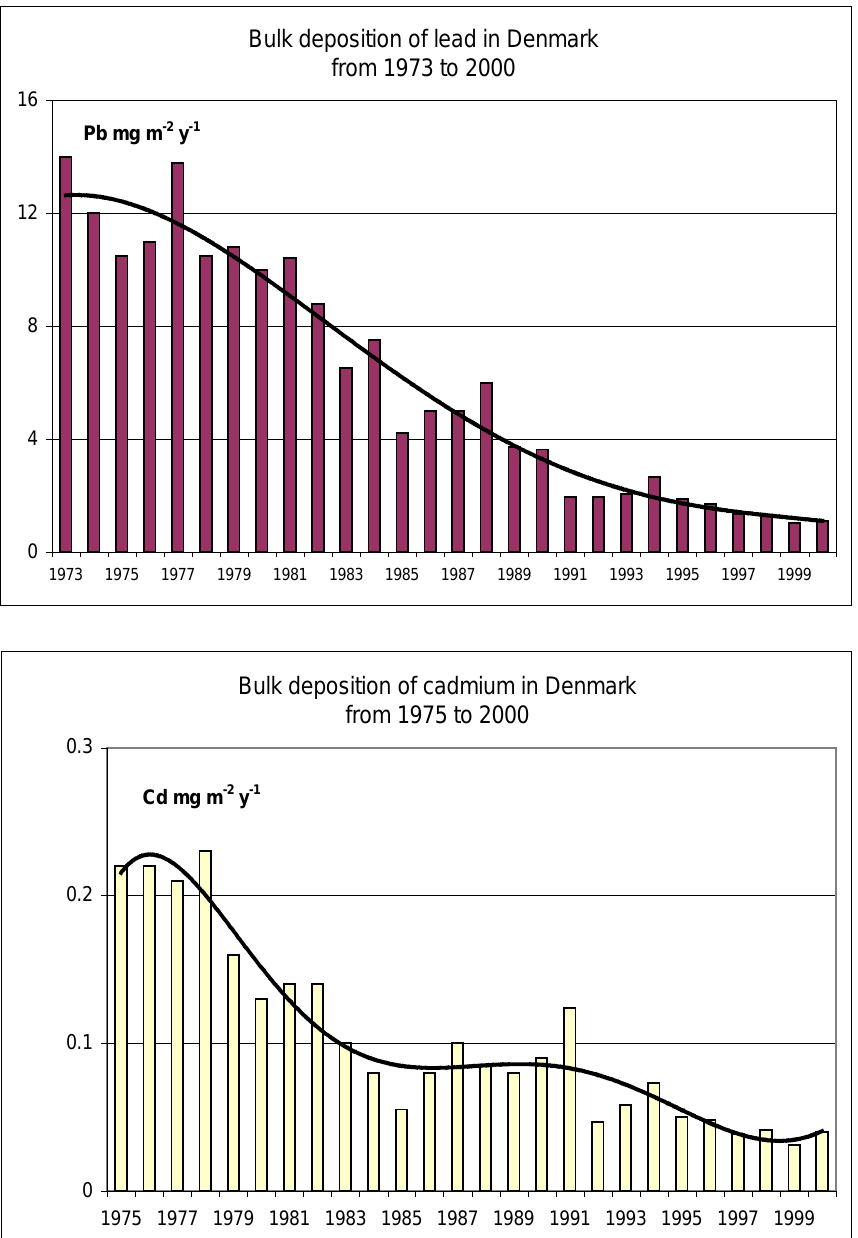
FIGURE 1. Yearly bulk deposition of lead (Pb) and cadmium (Cd) measured at rural forest sites in Denmark since 1973. The fitted lines indicate the